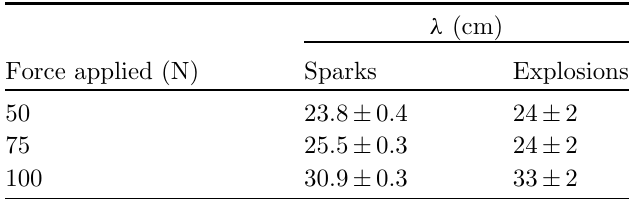
Table 2. Characteristic length l in cm of the distribution for different forces applied.